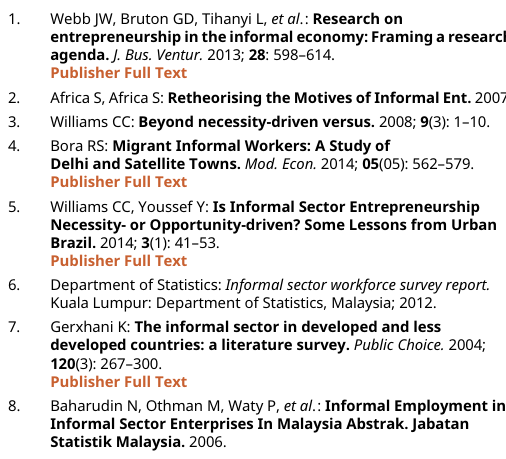
Figshare: Measuring the motives of informal entrepreneurs https://figshare.com/s/c70b053eacb5ac8a24e4. 20